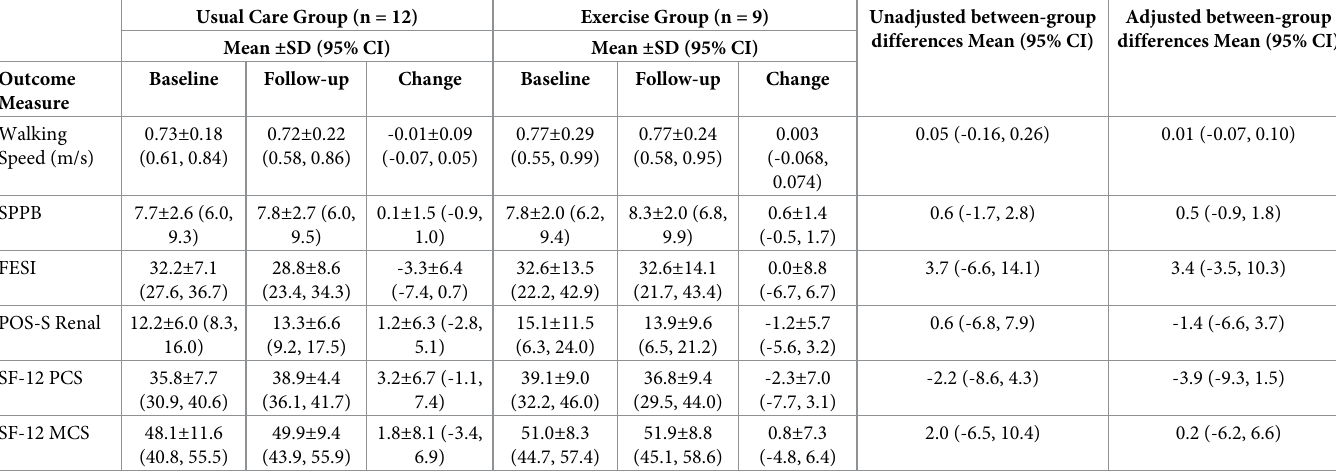
Table 3. Between-group differences in physical function and patient reported outcomes.